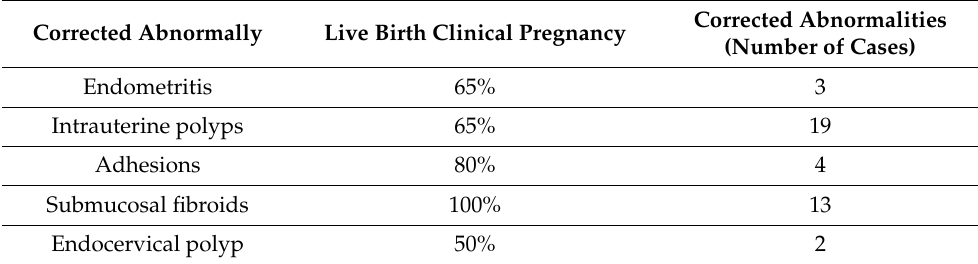
Table 2. Live birth in the study group according to the detected and corrected abnormally. Corrected Abnormally Live Birth Clinical Pregnancy